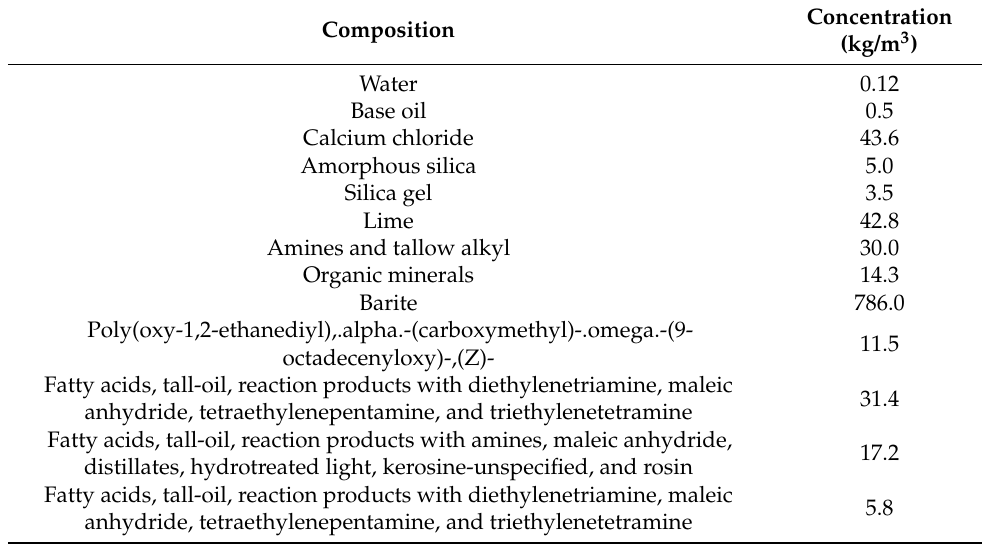
Table 1. Composition of the oil-based drilling